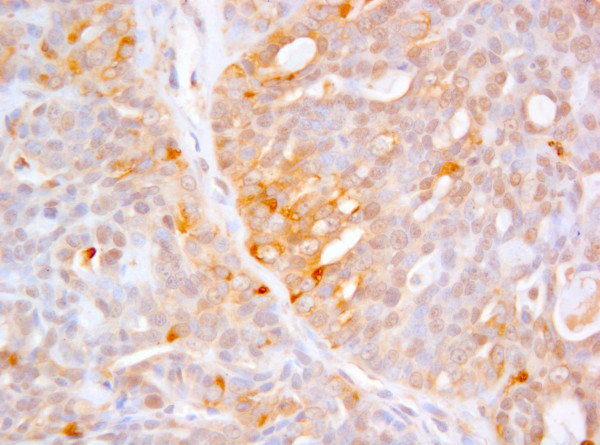
Cat. Mammary gland. Strong cytoplasmic and light nuclear VEGF-C positivity in cells of solid carcinoma. 40X.